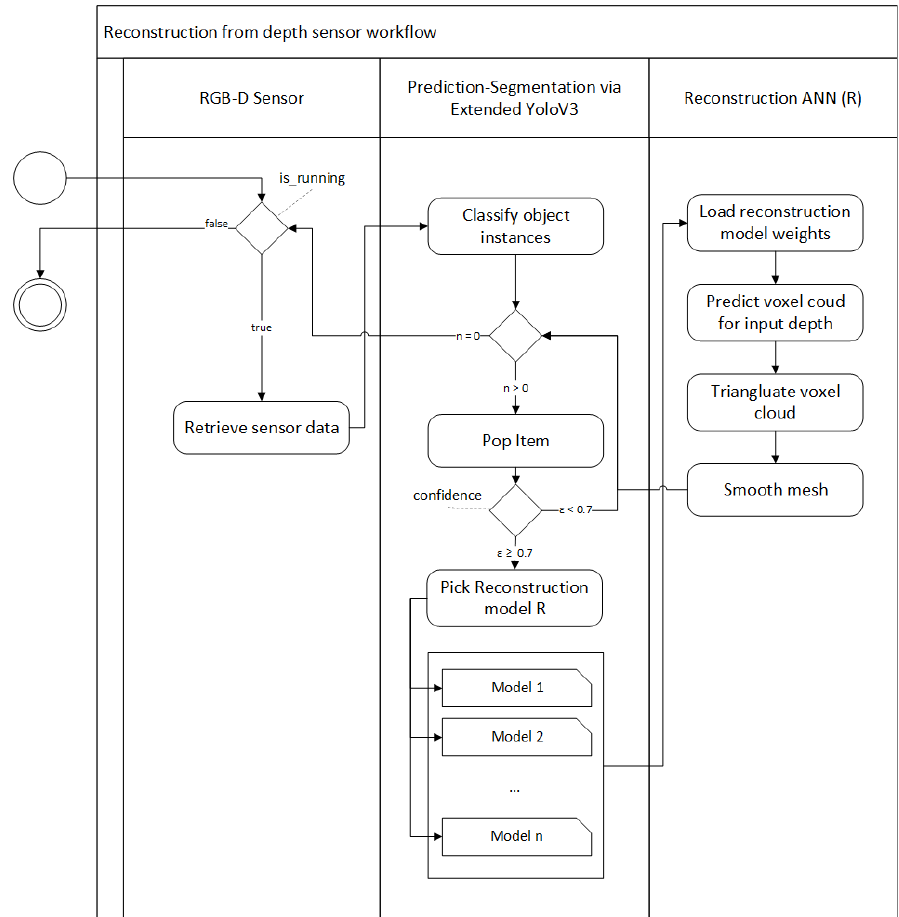
Figure 4. Workflow of object reconstruction from sensor